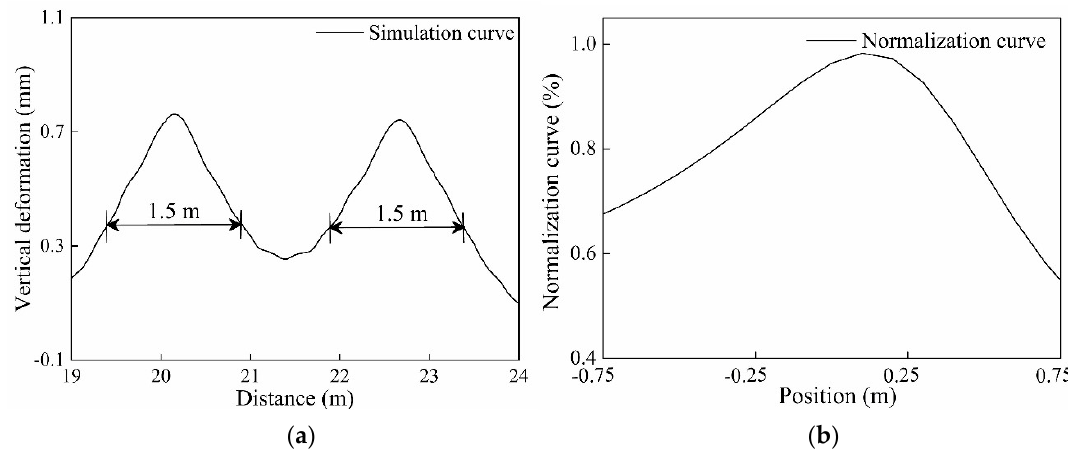
Figure 12. The detection area and the normalization curve: ( a ) The schematic diagram of the detection area; ( b ) The normalization curve of the wheel flat.